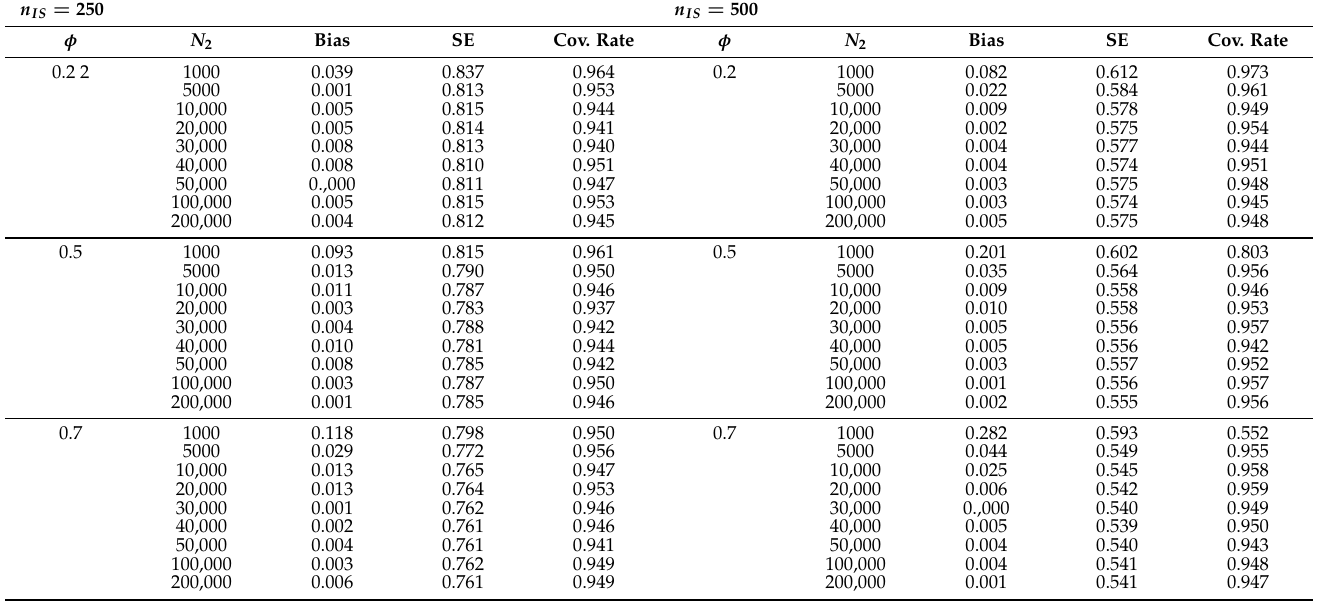
Figure 4. Bias, standard error, and coverage rate for the mean parameter, according to the ratio and φ . Blue points n IS = 250, green points n IS = 500. Table 2. Bias, standard errors, and coverage rates of the inverse sampling estimates of the mean, according to the bias, dataset size, and extracted subsample